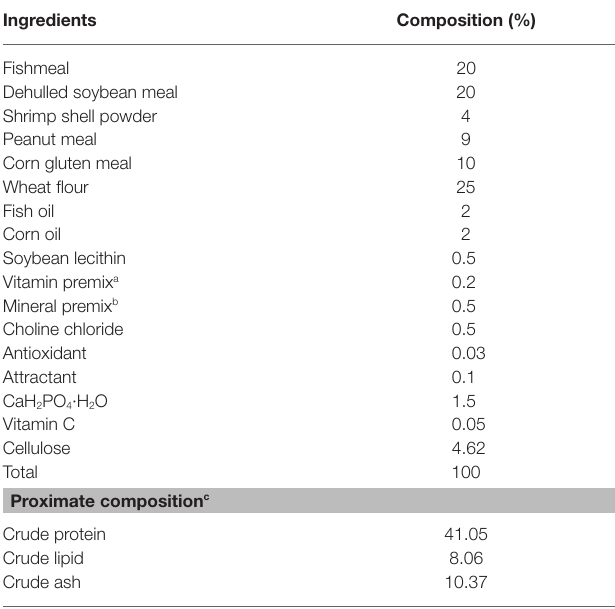
TABLE 1 | The formula and proximate composition of the basal